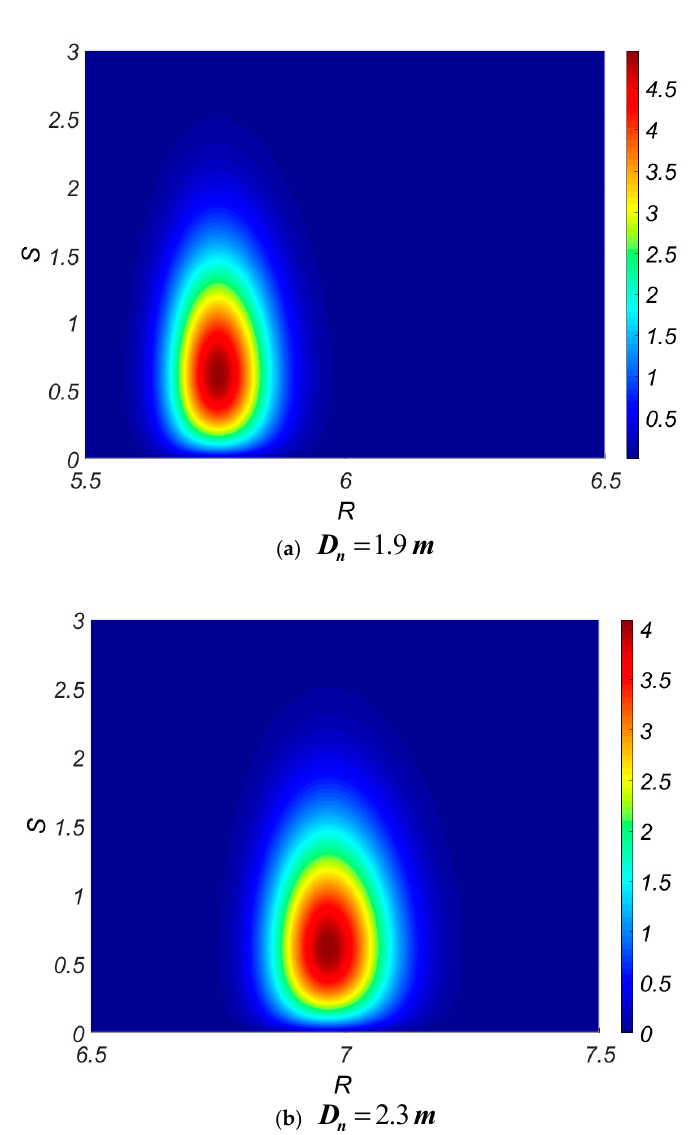
21 of 28 m D [unit, ].